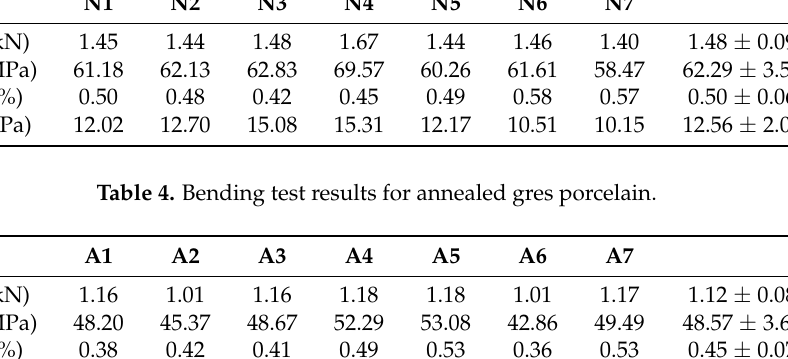
Table 3. Bending test results for not annealed gres porcelain.